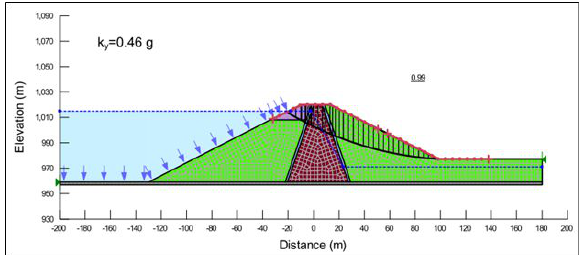
Fig. 9. Critical Slip Surface of Downstream